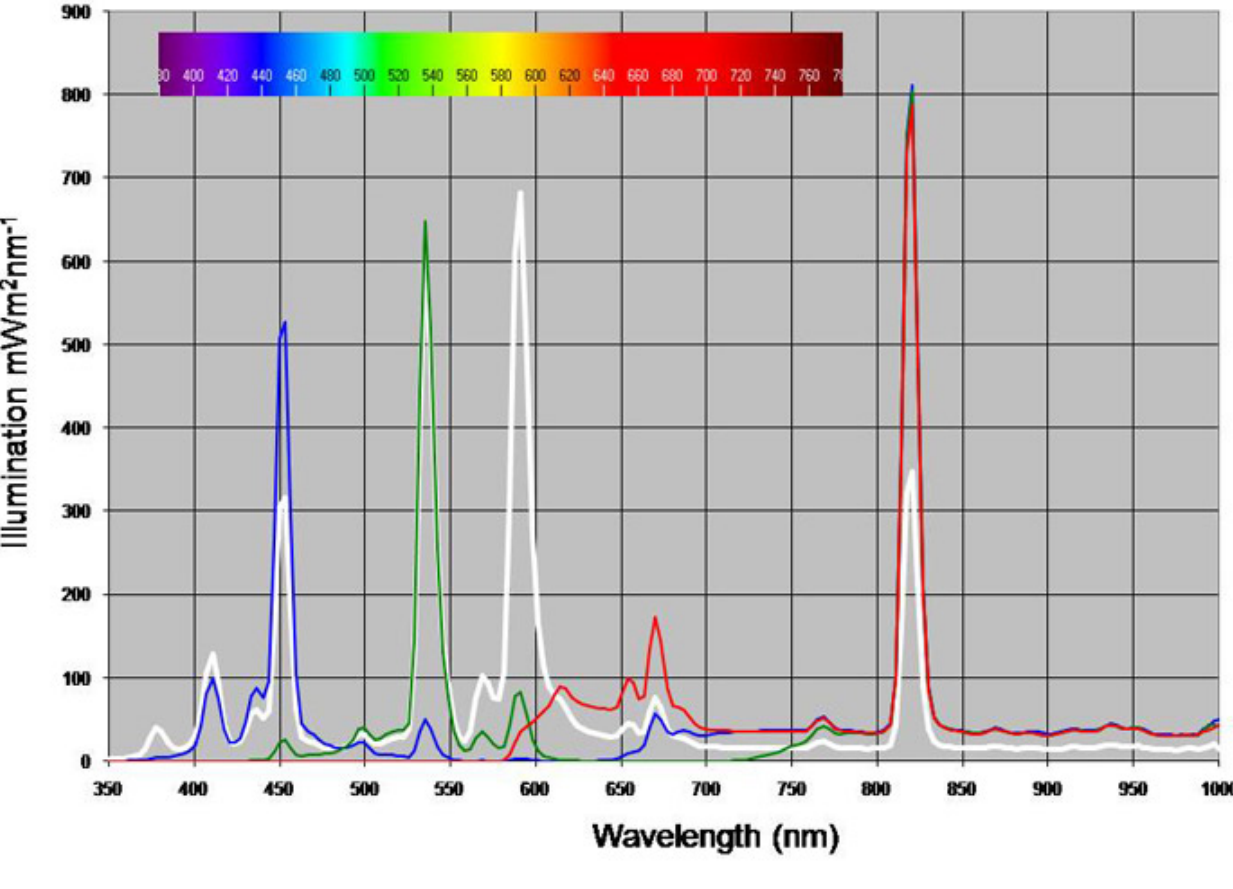
Fig. 4. The spectral shape of, respectively, the diffuser filter (white line), the blue filter (blue line), the green filter (green line), and the red filter (red